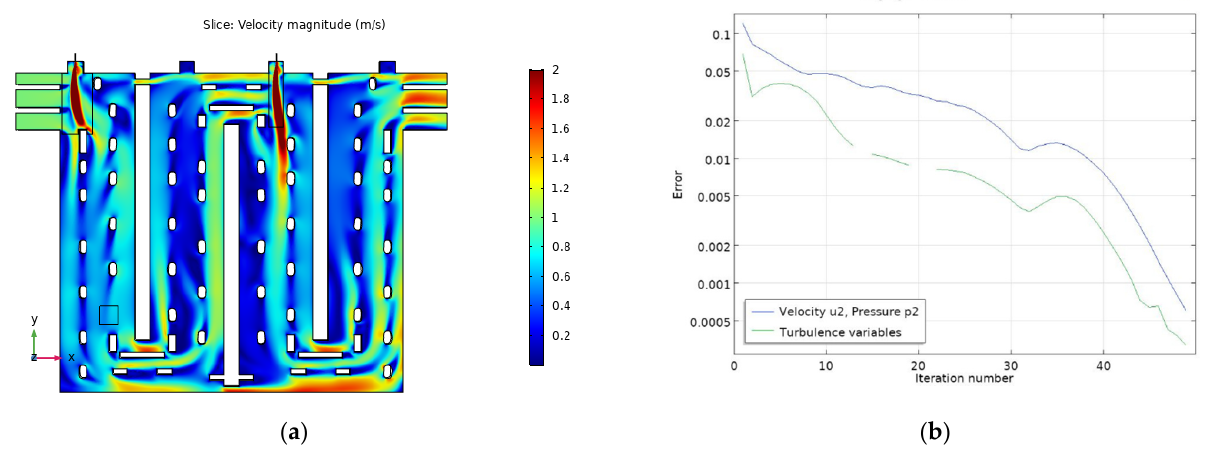
Figure 11. Model 8: Without artificial diffusion using mesh 3. Initial values for the Newton Raphson method are the results of model 7. ( a ) Velocity field (dimensions m/s); ( b ) Segregated solver plot.